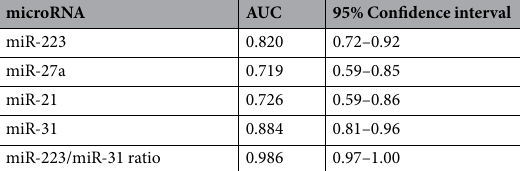
miR-223 co-segregated with free protein. Taken together, these experiments provided evidence that up to 75% of extracellular miR-223 co-elutes with EVs present in infected effluent including EVs that are positive for the neutrophil marker CD15.